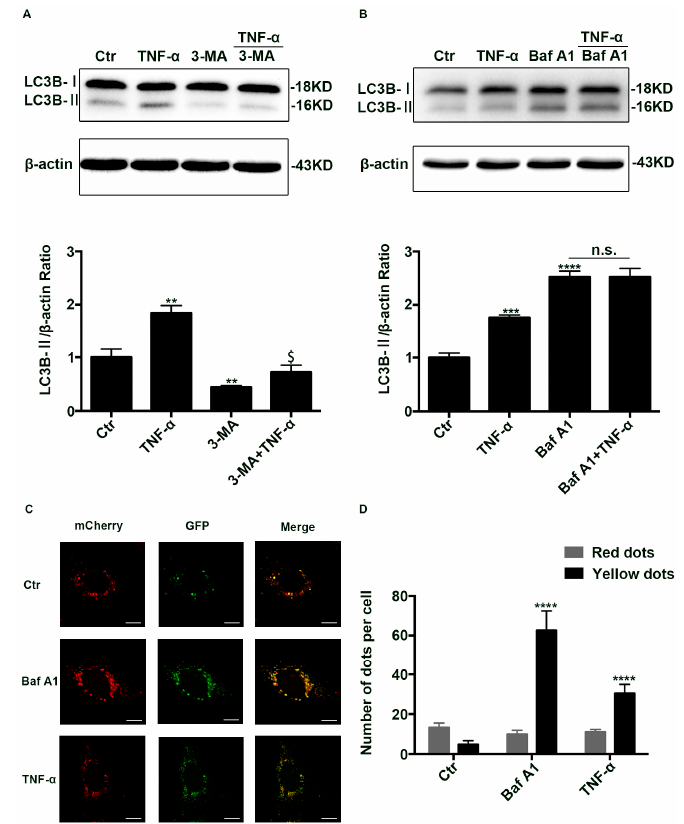
Figure 2. The inhibition of autophagic degradation in TNF- α treated cells. ( A , B ) Western blotting analysis of LC3B-II in Caco-2 cells treated with TNF- α (10 ng/mL) in the presence or absence of 3-MA (5 mM, 24 h) or Baf A1 (100 nM, 4 h) pretreatment. ( C ) Representative images of Caco-2 cells transfected with ad-mCherry-GFP-LC3B adenovirus after TNF- α (10 ng/mL, 48 h) or Baf A1 treatment (100 nM, 4 h). Scale bar: 15 μ m. ( D ) The number of red and yellow LC3 dots per cell were counted under confocal microscope (>30 cells/group). Data were shown as mean ± SD and replicated three times. ** p < 0.01, *** p < 0.001, **** p < 0.0001 versus control group. $ p < 0.05 versus 3-MA group. n.s., no significant. Ctr, control group; 3-MA, 3-methyladenine; Baf A1, Bafilomycin A1.